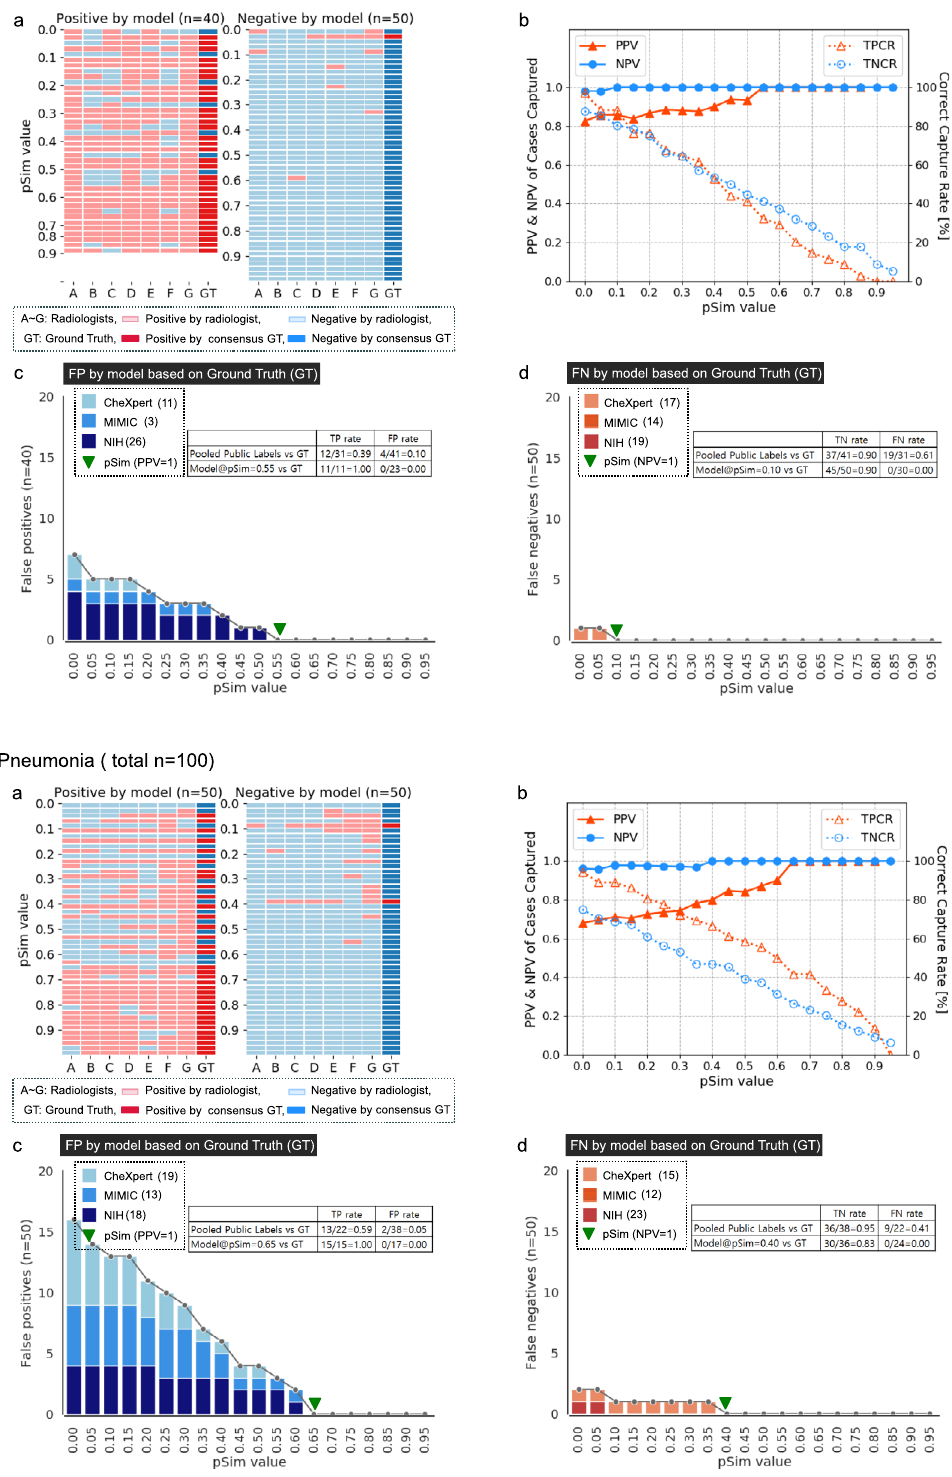
Fig. 3 Automated-labeling model performance applied to three open-source CXR datasets, compared to consensus ground truth of seven expert radiologists, applied to the pulmonary edema and pneumonia labels. Please refer to Fig. 2 for a – d